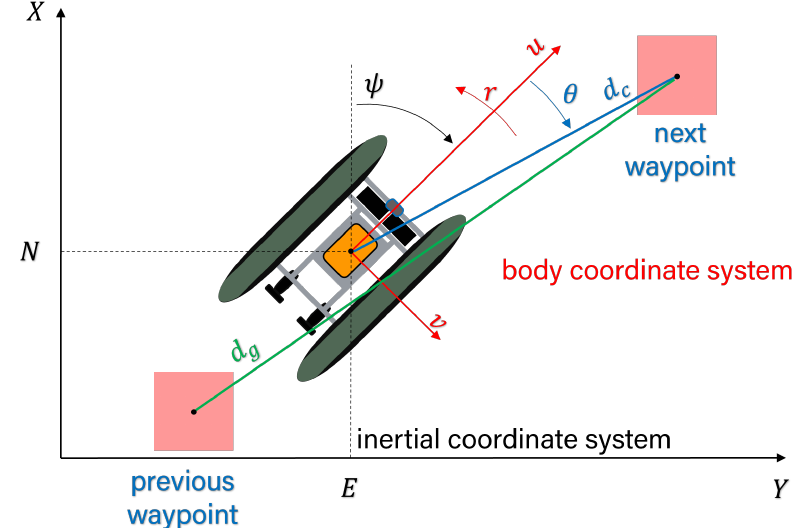
Figure 3. The vehicle’s state in the inertial and the body fixed